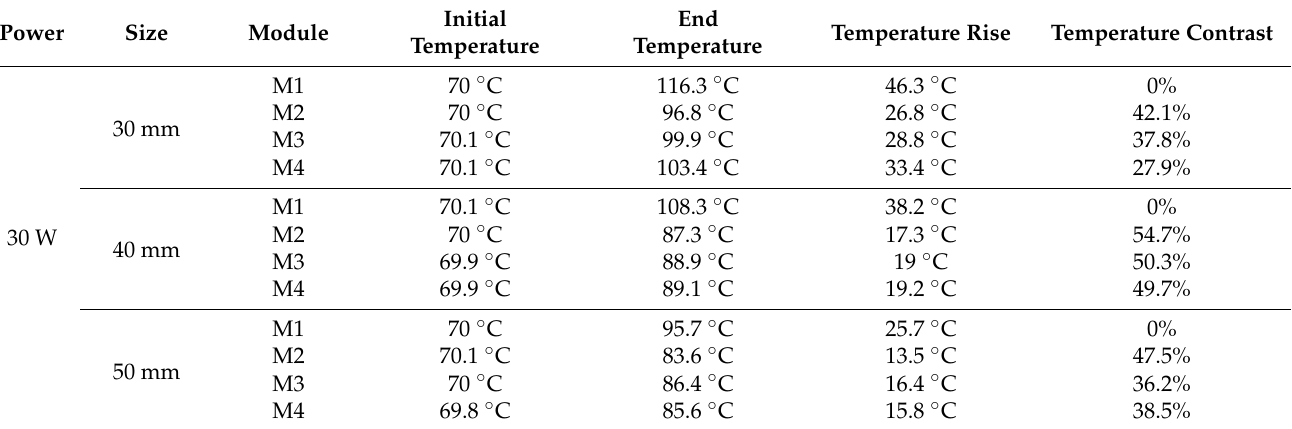
Table 5. The temperature of different size heat sources under each cooling module working at 30 W power for 10